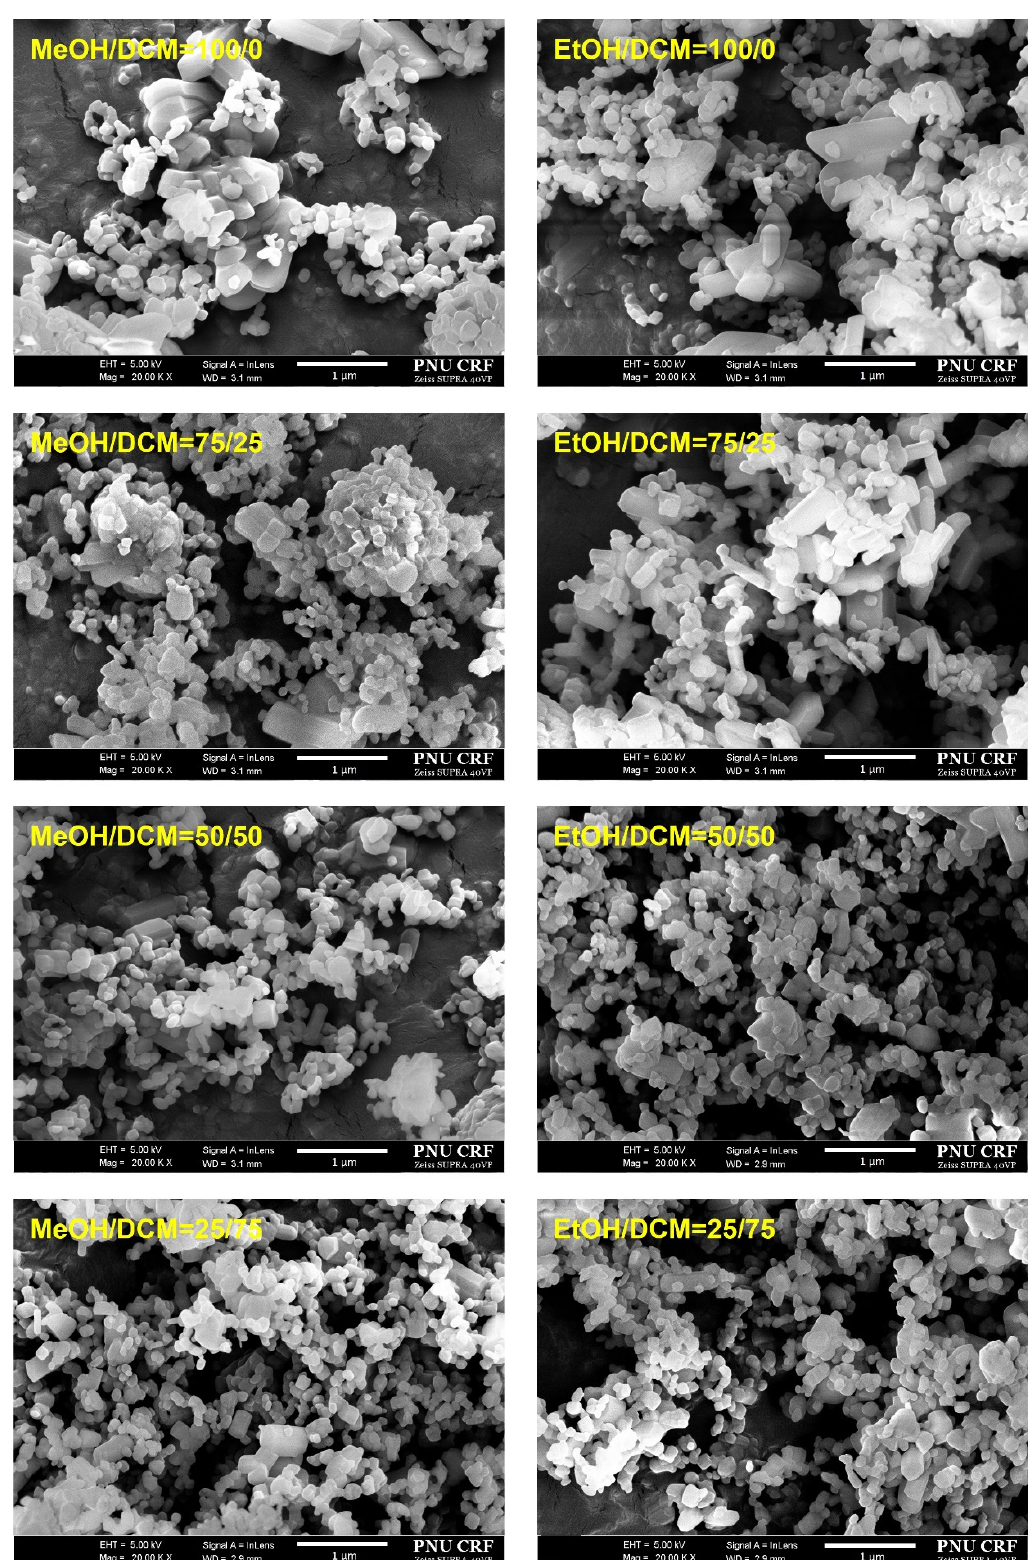
Figure 2. Scanning electron microscopy images of the trans -resveratrol nanoparticles prepared by the SAS process using different alcohol–dichloromethane mixtures. MeOH: methanol, DCM: dichloromethane, EtOH: ethanol.